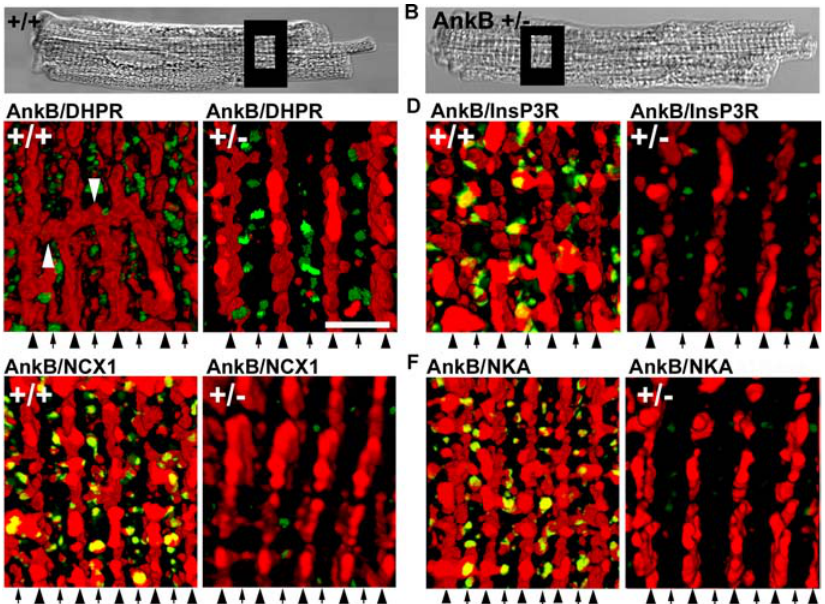
Figure 1. NCX1, NKA, and InsP 3 R Localization Require Ankyrin-B Boxes in differential interference contrast images (A and B) represent sites that were imaged in (C–F). Immunolocalization of ankyrin-B (red) and (C) DHPR (green), (D) InsP 3 R (green), (E) NCX1 (green), and (F) NKA (green) in wild-type (left) and ankyrin-B þ / (cid:1) cells (right). Ankyrin-B þ / (cid:1) myocytes were labeled and imaged using identical protocols. M-lines (middle of A-band) are denoted by arrowheads; T-tubules over I-bands are denoted by arrows. Scale bar ¼ 2 l m. Distance between arrowheads is ; 1.8 l m. Images represent at least twenty Z -sections at 0.18- l m intervals. In (C), perpendicular axial branches are denoted by white arrowheads. DOI: